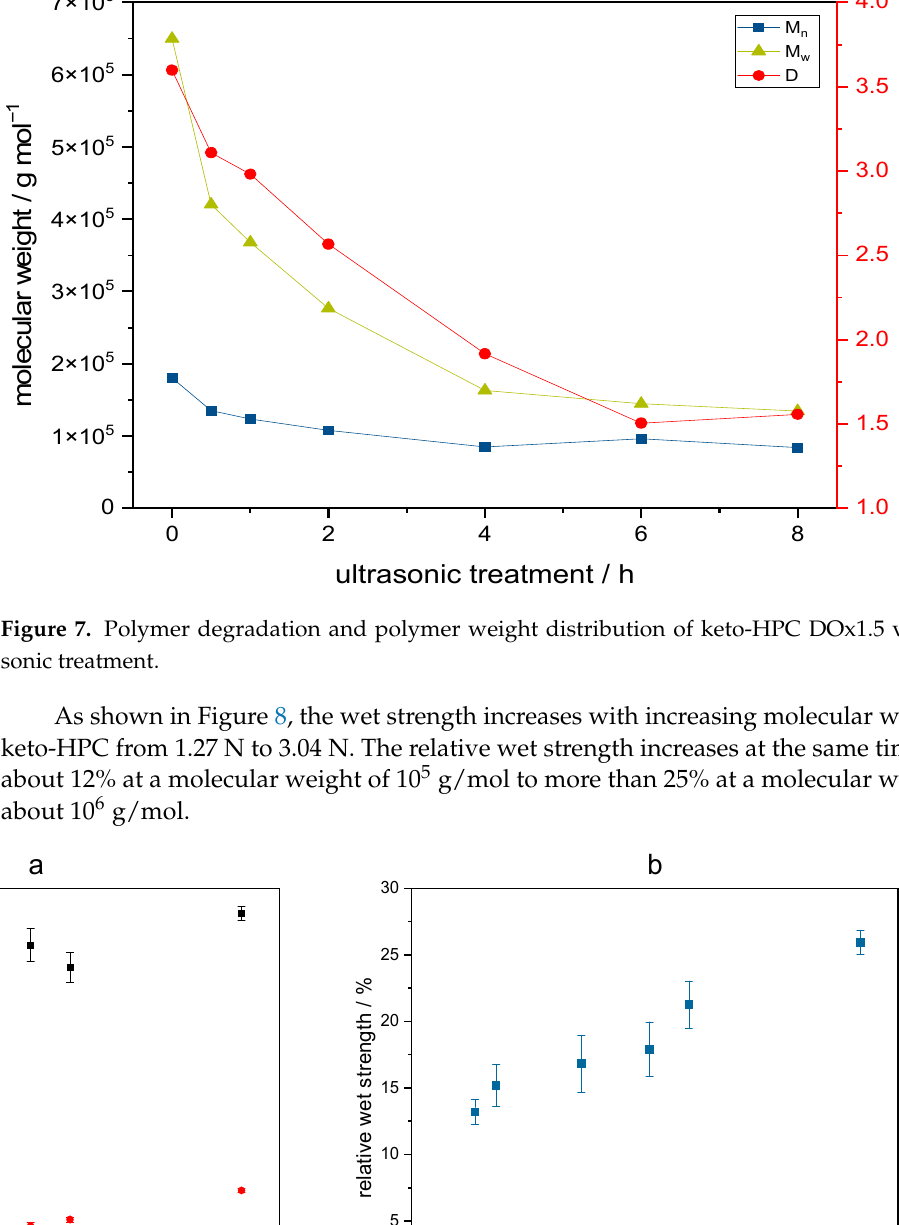
Figure 8. Influence of the weight average molecular weight of keto-HPC DOx1.5 in combination with PEI on dry and wet tensile strength ( a ) and relative wet strength ( b ) applied to cotton linter paper with a polymer amount of 1.5 wt%. However, the dry tensile strength also slightly increases. These results suggest that the molecular weight has a stronger impact on the wet strength than on the dry strength (see also the equation in Section 4.11). Here, keto-HPC is able to increase the area of con- tact between cellulose fibers even at low molecular weight, resulting in only a slight de- crease in dry strength. Low-molecular-weight keto-HPC is much less likely to have inter- fiber bonding between cellulose fibers, resulting in a loss of wet strength [5]. At a molec- ular weight <1.5 × 10 5 g mol − 1 , the wet strength results achieved are only slightly higher than the PEI reference. Therefore, its assumed that at this degradation level (and